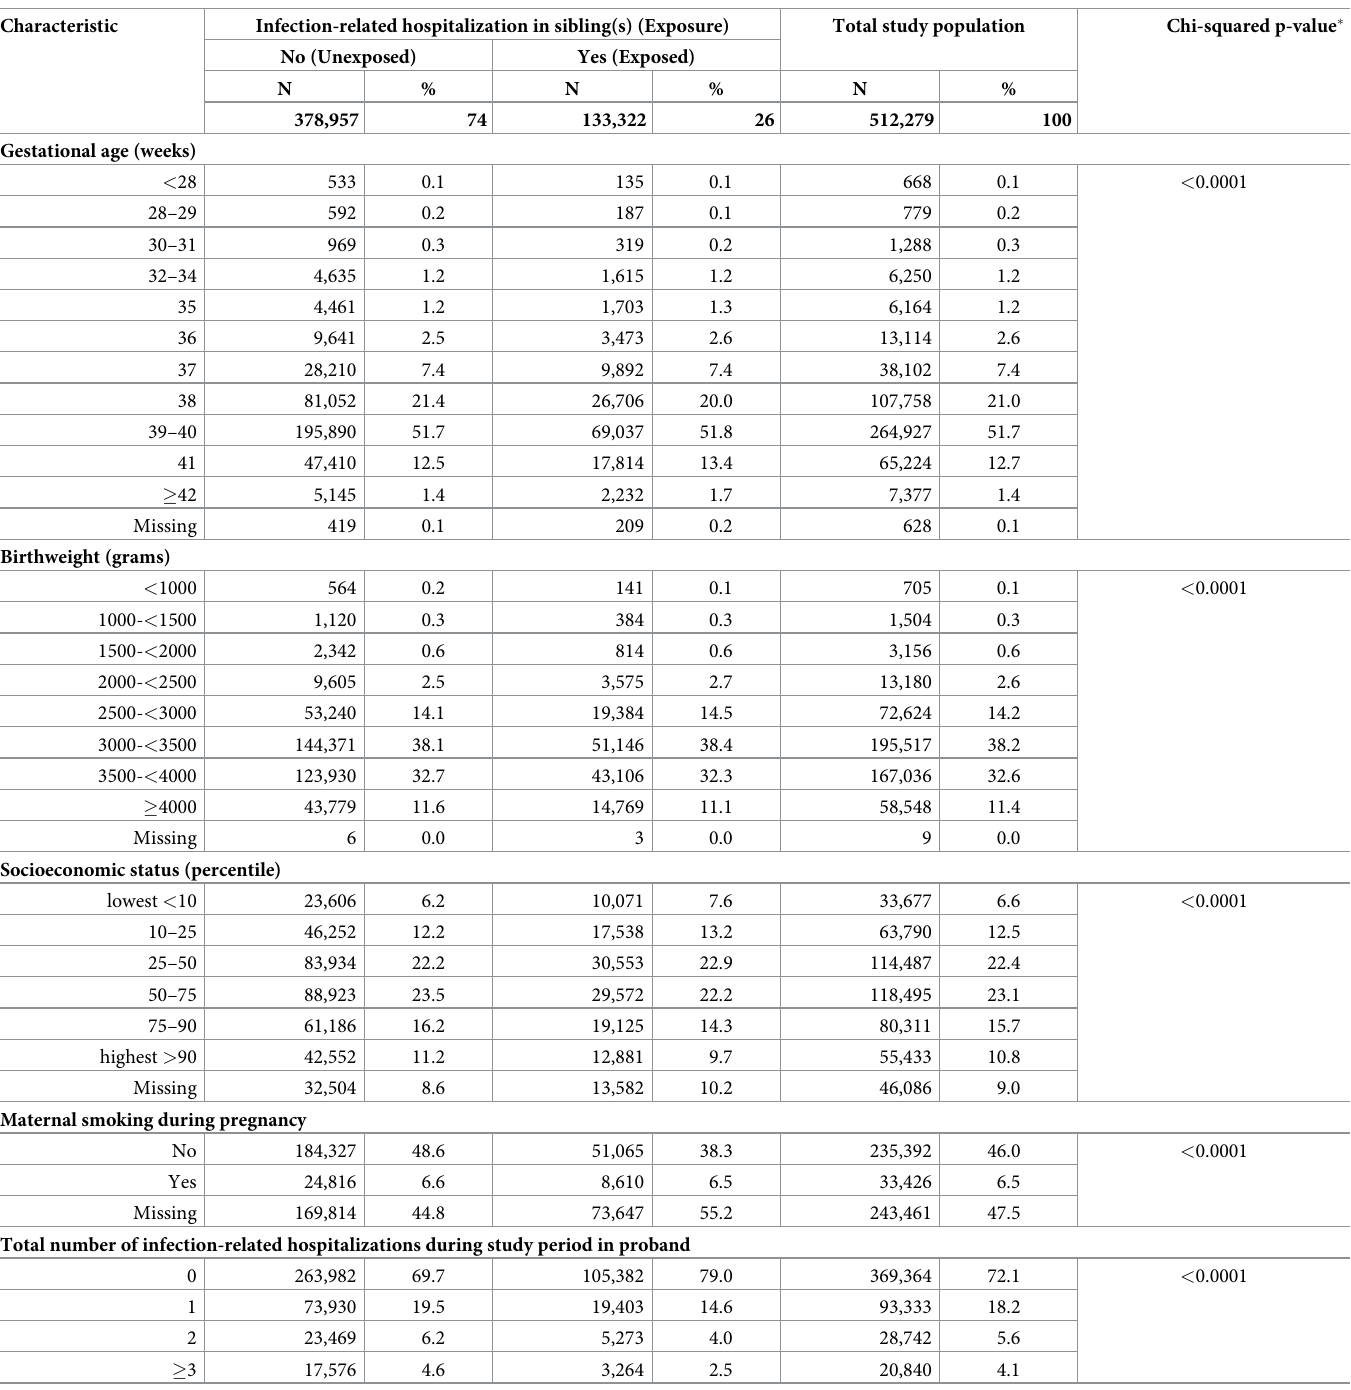
� Chi-square test of independence for exposure status and dichotomous and categorized